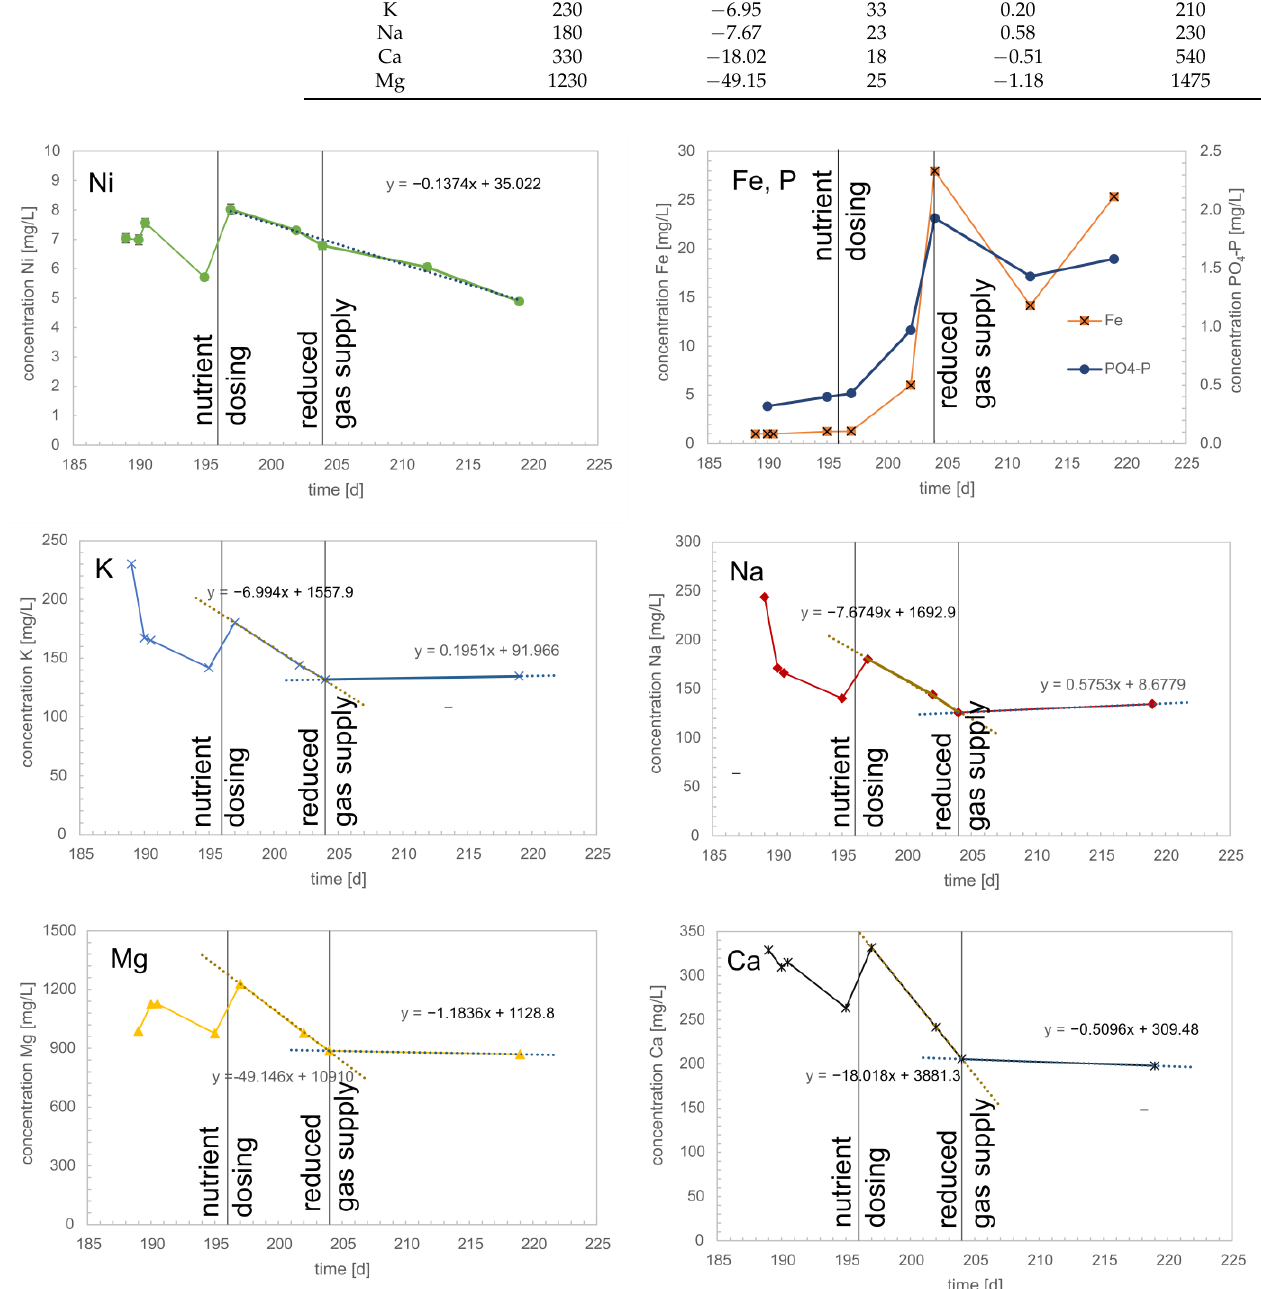
Figure 4. Trace element and mineral concentration in the trickling media and demand for Ni, Fe, P (as PO 4 -P), K, Na, Mg, and Ca after dosing on day 196, the trend lines for days 197 – 204 and days 204 – 219 are drawn as dotted lines.